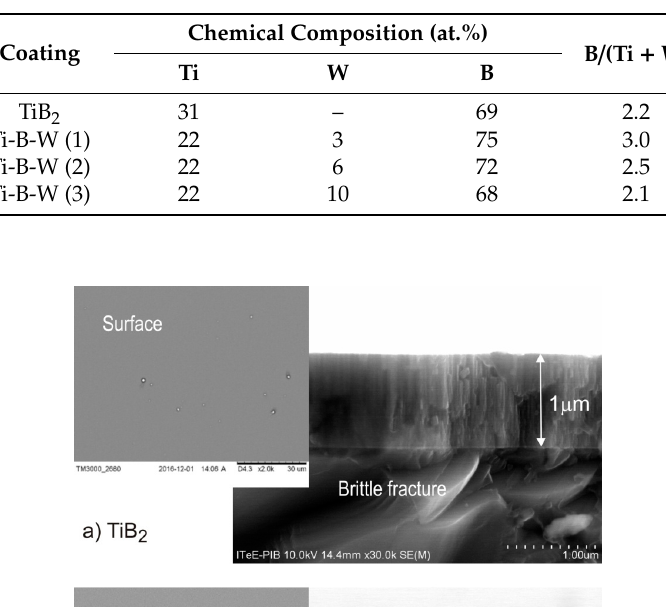
Table 3. The results of investigations of the chemical composition for TiB 2 and Ti-W-B coatings, which were made using the WDS method.